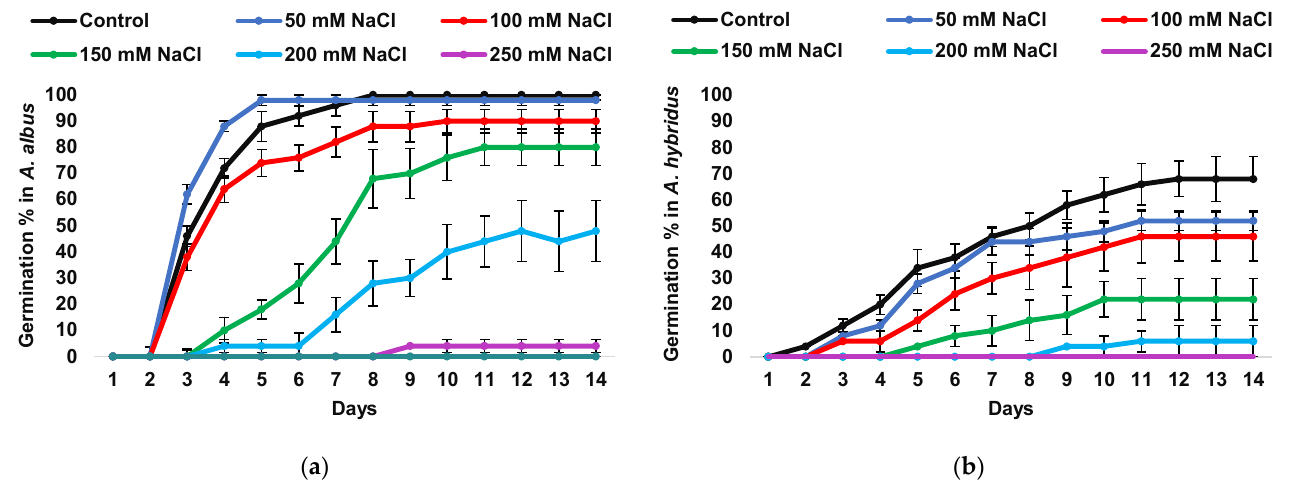
Figure 2. Germination percentage during 14 days in the presence of increasing concentrations of NaCl in Amaranthus albus ( a ) and A. hybridus ( b ).